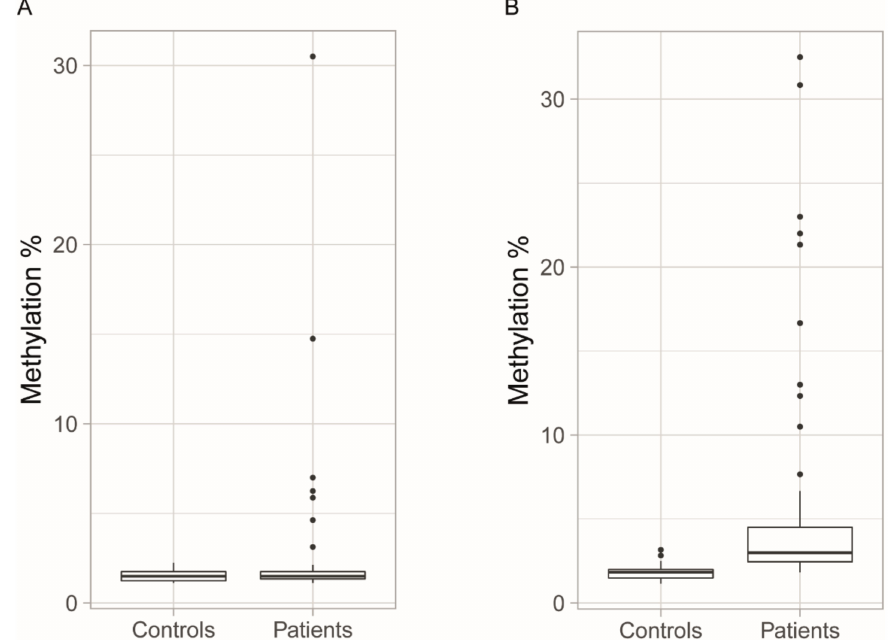
Figure 2. Mean methylation levels of all the CpG sites ( A ) upstream and ( B ) downstream of the CTG repeat. In approximately 10% of the patients, the upstream CpG sites were hypermethylated compared to in the control group, while the methylation levels of downstream CpG sites were significantly higher in patients than in controls. Boxplots indicate medians and quartiles, and the dots indicate the levels of methylation for patients who are